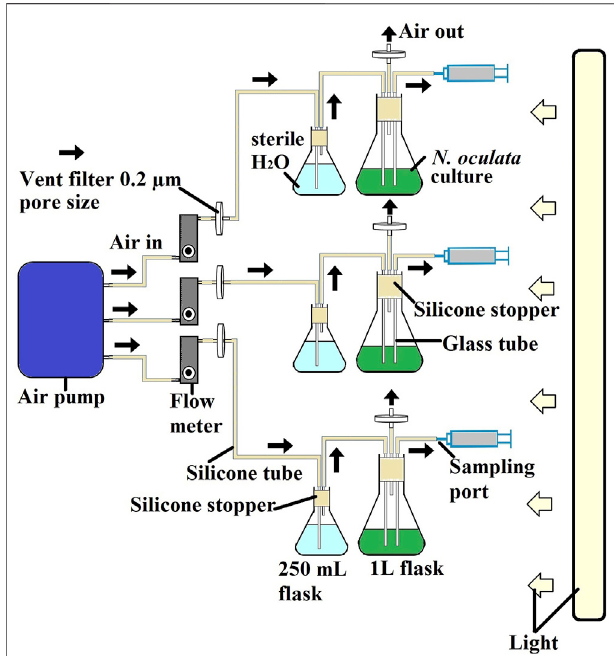
FIGURE 1 | Schematic diagram of experimental cultivation system for selecting two-time points for LFQ proteomics experiments. All experiments were conducted at room temperature at 20 ° C and illuminated under 130 μ mol μ mol m − 2 s − 1 under a 12-h/12-h (day/night) cycle. The cultures were subjected to continuous fi ltered aeration and bubbled at 2